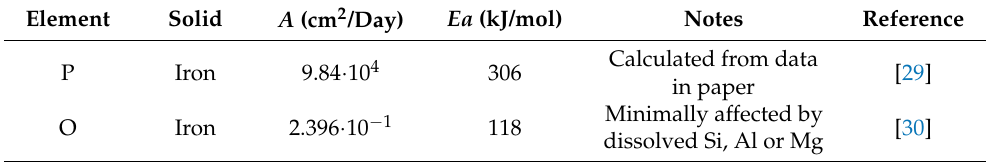
Table 1. Constants for Equation (4) to calculate diffusion